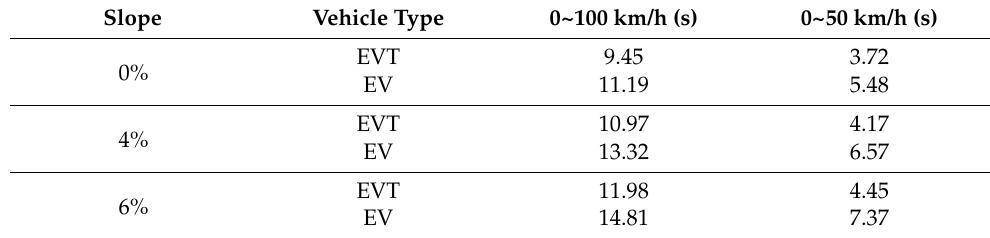
Figure 17. Acceleration time at different road slopes: (a) Acceleration time from 0 to 100km/h at 0% slope; (b) Acceleration time from 0 to 50km/h at 0% slope; (c) Acceleration time from 0 to 100km/h at 4% slope; (d) Acceleration time from 0 to 50km/h at 4% slope; (e) Acceleration time from 0 to 100km/h at 6% slope; (f) Acceleration time from 0 to 50km/h at 6% slope. The acceleration times of the EVT and the EV are shown in Table 3. Table 3. Acceleration times of EVT and EV.